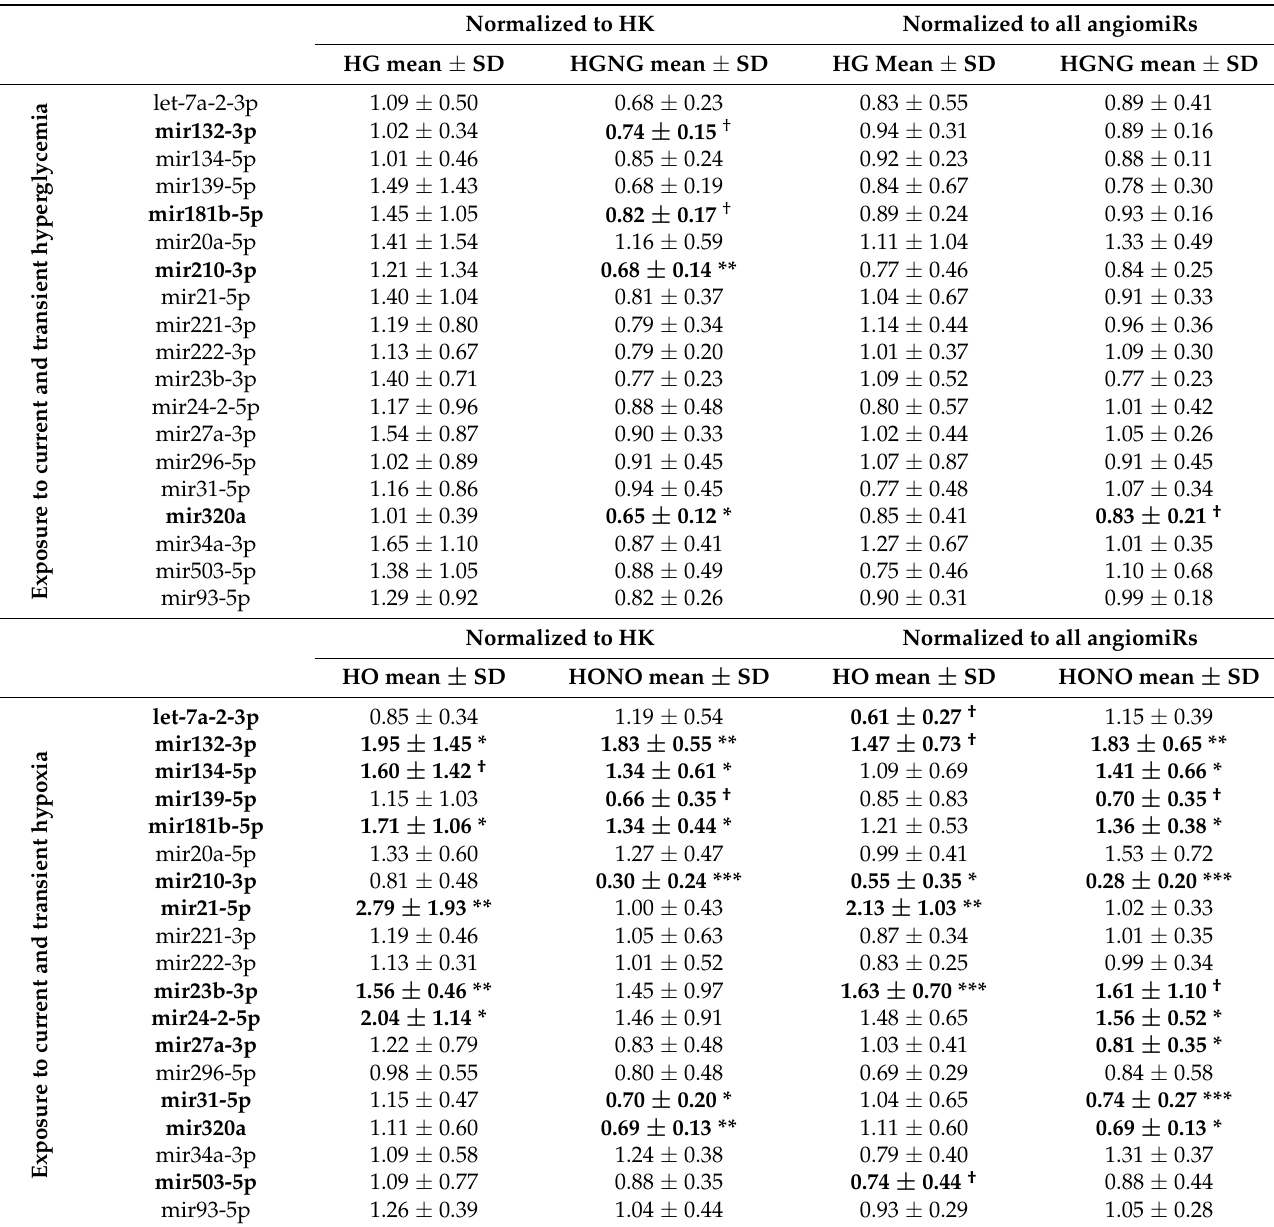
Table 1. AngiomiR expression changes after current exposure to hyperglycemia (HG) or hypoxia (HO) and after reversal to control conditions (HGNG and HONO,